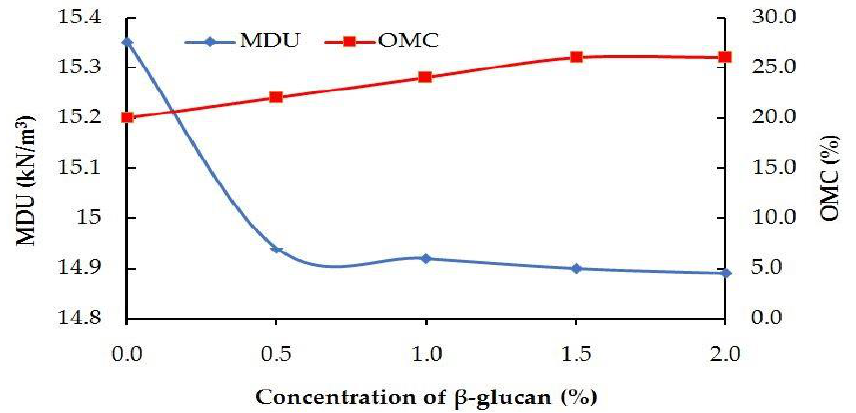
Figure 5. Compaction characteristics of β -glucan-treated soil.